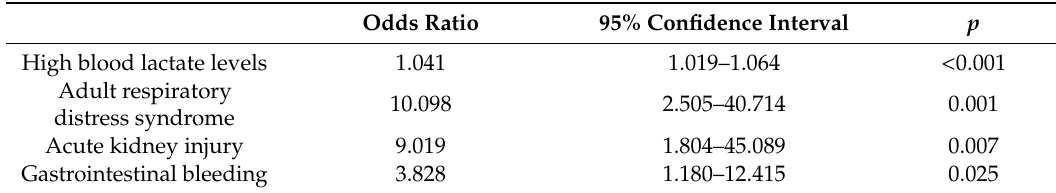
Table 5. Multivariate analysis of independent risk factors associated with fatality in patients with critically ill